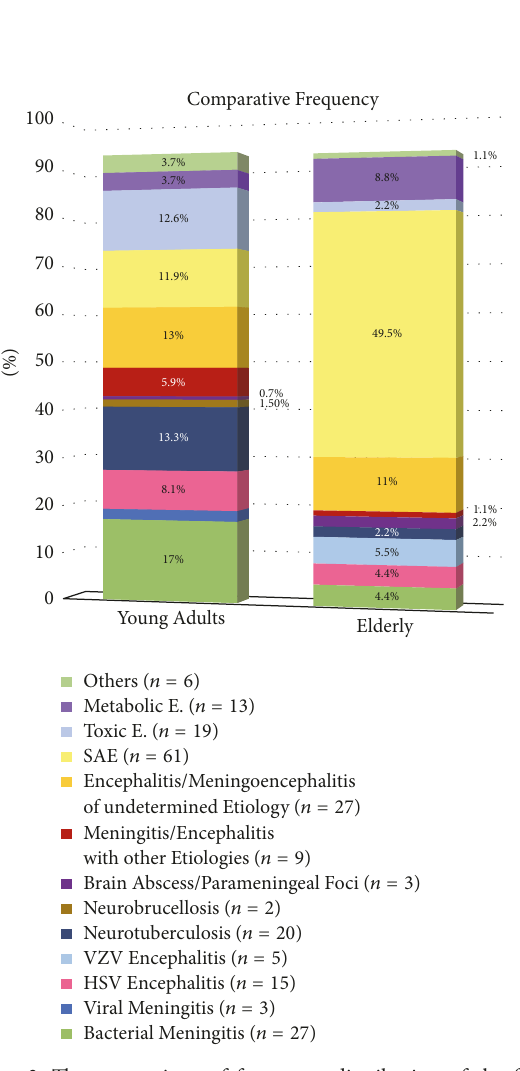
Figure 3: The comparison of frequency distribution of the final diagnosisinpatientswithfebrileencephalopathysyndromebetween the elderly ( ≥ 65 years) and young adults ( < 65 years). HSV: Herpes Simplex Virus ; VZV: Varicella Zoster Virus ; SAE : Sepsis Associated Encephalopathy; E .: